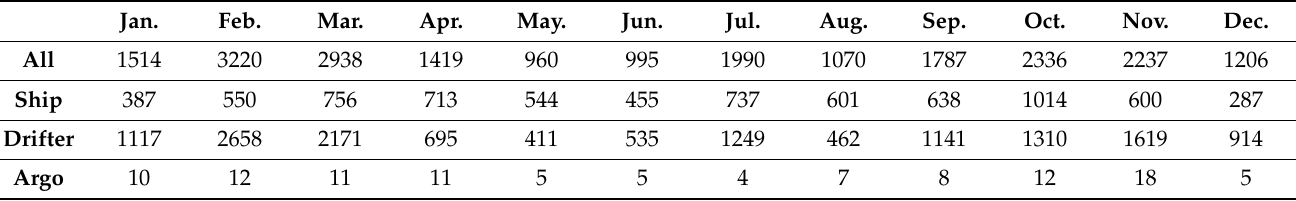
Table A1. The amount of data of each observation measurements of iQuam in each